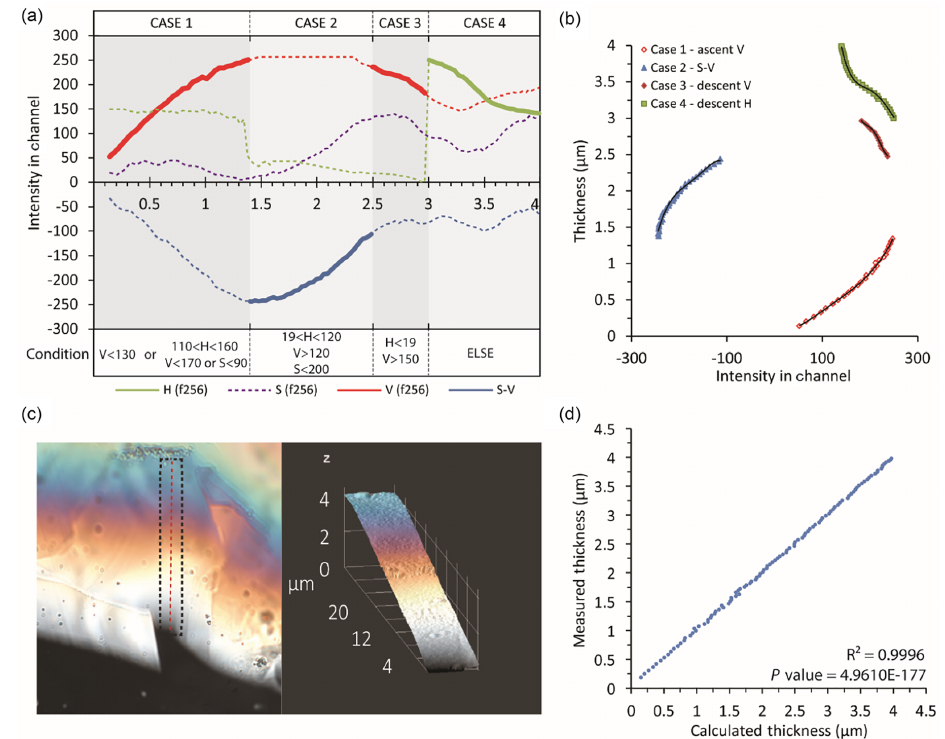
Figure 6. (a) Variation in components of color-model HSV with increasing thickness along the calcite wedge profile. Solid lines indicate the range in which that color component is used to calculate thickness. (b) Polynomial distribution for each interval. Table 2 gives the equations of each color component. (c) Tridimensional Thickness plots of calcite wedge area generated with image analyzer software using criteria and equations described in the text. (d) Validation profile of the measured thickness of the calcite wedge ETH-W2 and the thickness calculated using the regression equations described in Table 2. For the validation data, we used a different set of pixels than those used for the calibration equations. Light intensity was saturated at a calcite thickness of